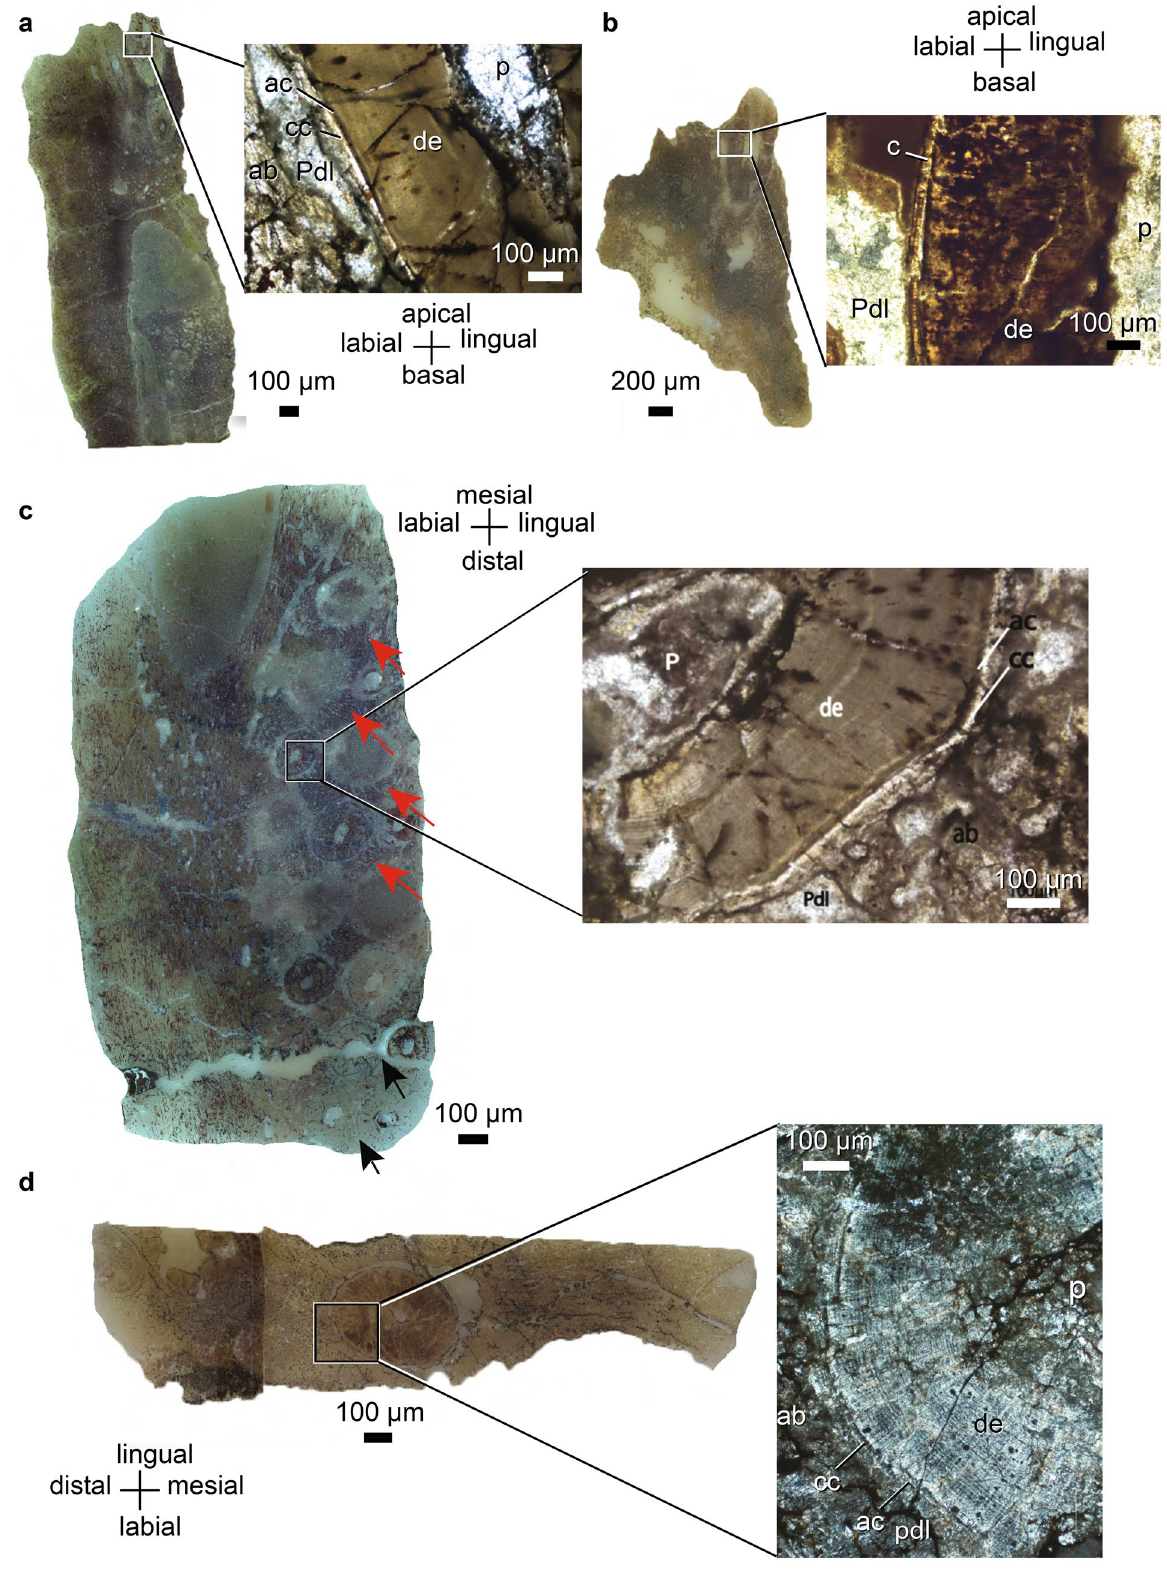
Figure 2. Dentary histological sections of Endothiodon sp. specimens from the K5 Formation, Metangula Graben, Mozambique. ( a ) Coronal section of the three-toothrow dentary of PPN2014-70-3. ( b ) Coronal section of the single-toothrow dentary of PPN2014- 64-17A. ( c ) Horizontal section of the three-toothrow dentary of PPN2014-70-3. The red arrows depict the trails left by the tooth migration and the black arrows depict the cross-cutting patterns between tooth generations, indicating that there is a labial to lingual migration of the teeth through development. ( d ) Horizontal section of the single-toothrow dentary of PPN2014-15. ab alveolar bone, ac acellular cementum, c cementum, cc cellular cementum, de dentine, p pulp cavity, pdl periodontal ligament